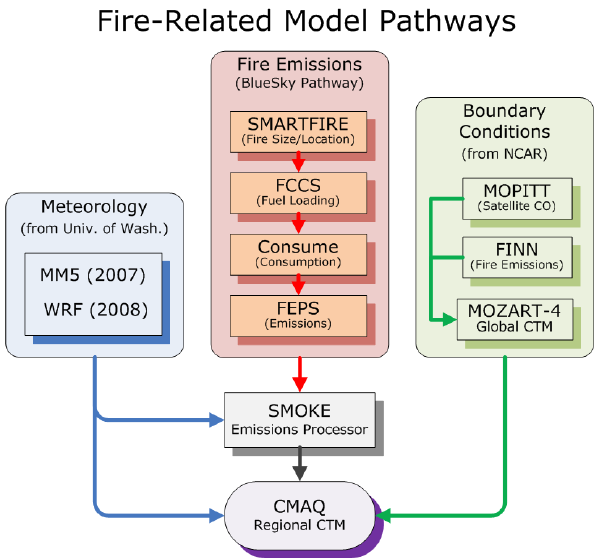
Figure 2. Fire-related modeling pathways used in the AIRPACT-3